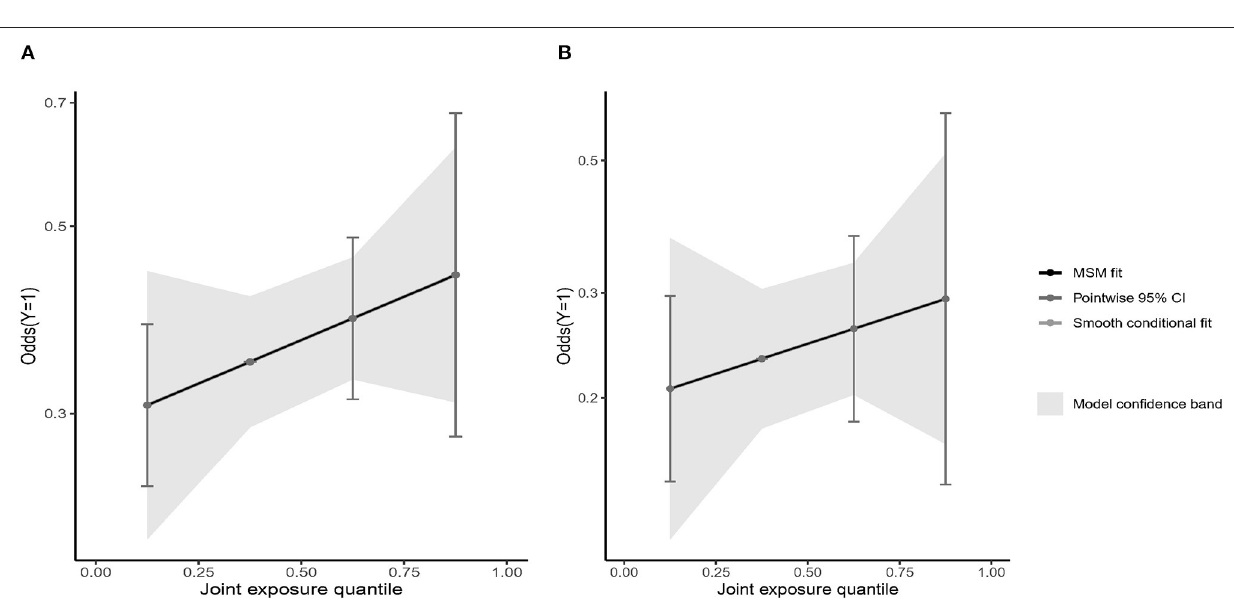
FIGURE 3 | Weights representing the proportion of the positive or negative overall effect for diet pattern in the quantile g-computation model with (A) the male group, and (B) the female